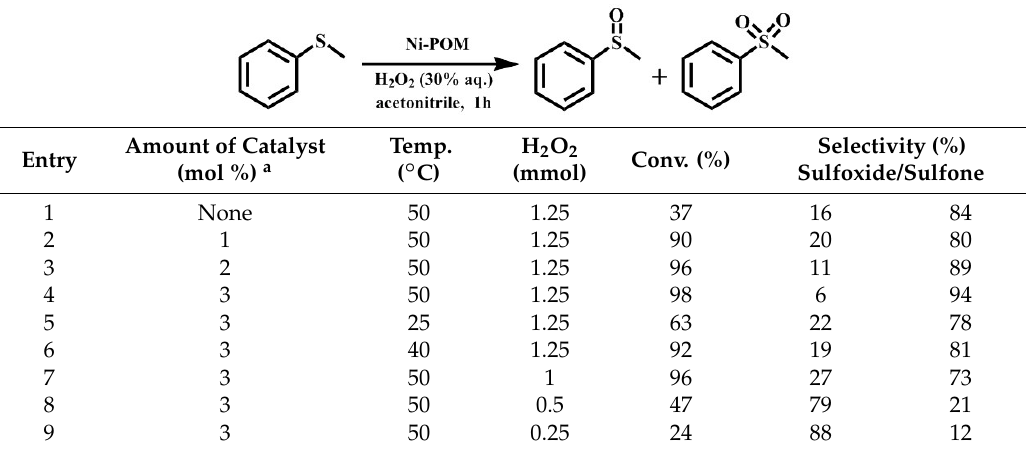
Table 2. Results for catalytic oxidation of thioanisole by compound 1 with H 2 O 2 in acetonitrile in different conditions after 1 h.